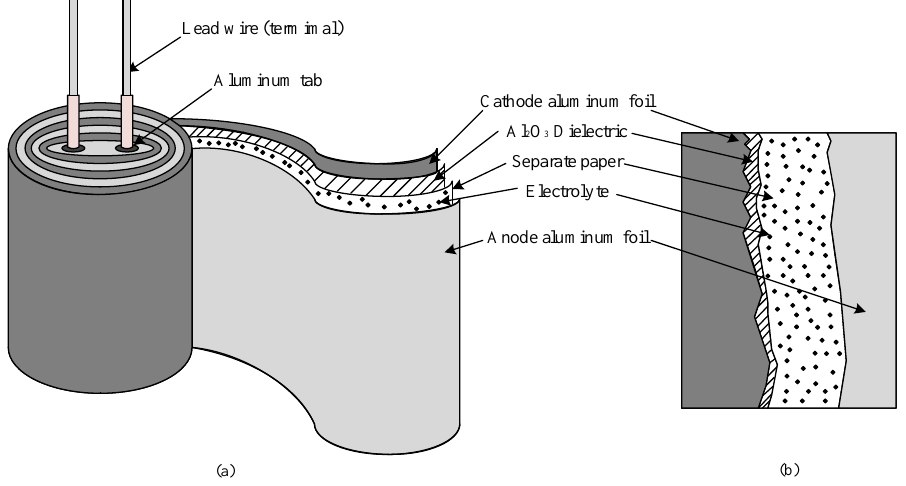
Figure7. Theconstructionsofthealuminumelectrolyticcapacitor(Al-Cap): ( a )thecylinderconstruction Figure 7. The constructions of the aluminum electrolytic capacitor (Al-Cap): ( a ) the cylinder and ( b ) the cross section of the cylinder construction and ( b ) the cross section of the cylinder shape.